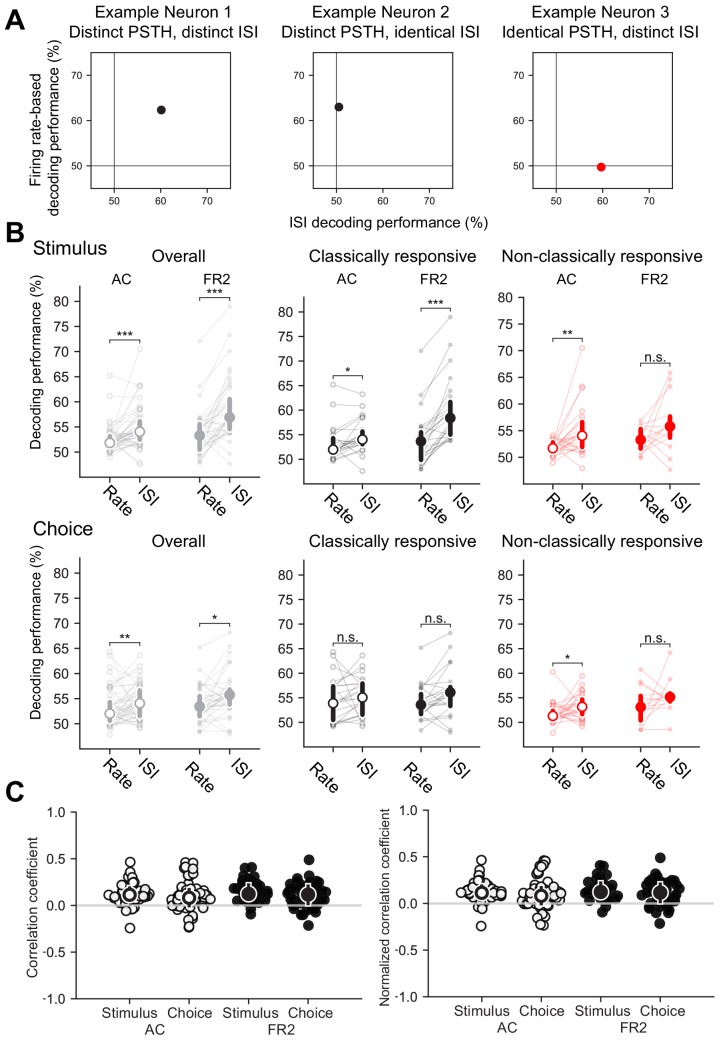
Information captured by ISI-based decoder distinct from conventional rate-modulated (inhomogeneous) Poisson decoder.(A) Decoding performance comparison for example neurons shown in Figure 2. Left, Both the trial-averaged firing rate and the ISI distributions can be used to decode stimulus category for this example neuron. Middle, Only the firing rate can be used to decode this example. Right, In this case, the ISI distributions can be used to decode even when the trial-averaged firing rate cannot. (B) Comparison of decoding performance for conventional rate-modulated decoder to our ISI-based decoder. Top row, stimulus decoding, bottom row, choice decoding. Left, Overall comparison for all cells. Right, Comparison for classically responsive and non-classically responsive cells (Stimulus Overall: ***pAC = 0.0001, ***pFR2 = 8 × 10−6, Stimulus Repsonsive: *pAC = 0.031, ***pFR2 = 4 × 10−5, Stimulus non-classically responsive: **pAC = 0.0019, n.s. pFR2 = 0.096, Choice Overall: **pAC = 0.0057, *pFR2 = 0.02, Choice Repsonsive: n.s. pAC = 0.031, n.s. pFR2 = 0.08, Choice non-classically responsive: *pAC = 0.004, n.s. pFR2 = 0.19, Wilcoxon signed-rank test). Individual cells shown and median with error bars designating bottom and top quartiles superimposed. (C) Left, Matthews correlation coefficient (MCC) between correct predictions of our ISI-based decoder and a conventional rate-modulated firing rate decoder. A MCC value of 1 indicates each decoder correctly decodes exactly the same set of trials, whereas −1 indicates each decoder is correct on complementary trials. Values close to 0 indicate that that the relationship between the decoders is close to chance. Typically, values from −0.5 to 0.5 are considered evidence for weak to no correlation (stimulus median and interquartile range: AC = 0.10, 0.09, FR2 = 0.11, 0.12; choice median and interquartile range: AC = 0.06, 0.15, FR2 = 0.08, 0.17). Right, Matthews correlation coefficient (MCC) rescaled by the maximum possible correlation given the decoding performance of each method remains fixed. This control demonstrates that the correlation values are not a result of weak decoding performance for one of the decoding methods (stimulus median and interquartile range: AC = 0.11, 0.11, FR2 = 0.12, 0.15; choice median and interquartile range: AC = 0.08, 0.17, FR2 = 0.11, 0.19). Source data has been provided in the spreadsheet titled ‘figure_5.csv’.